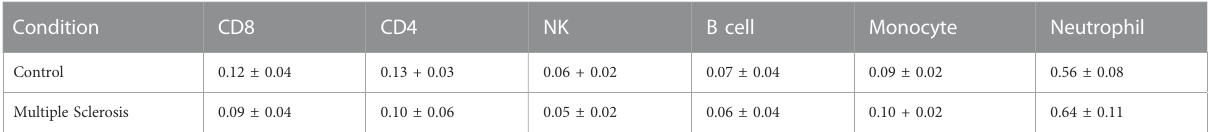
TABLE 3 Cell type composition